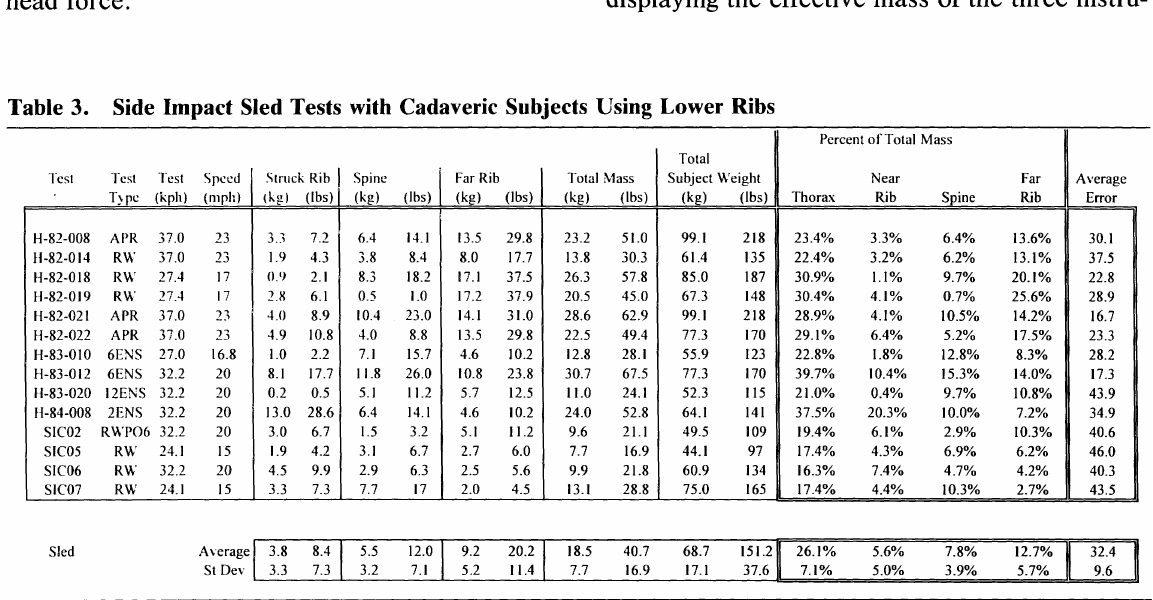
Table 3. Side Impact Sled Tests with Cadaveric Subjects Using Lower Ribs rest Test Test